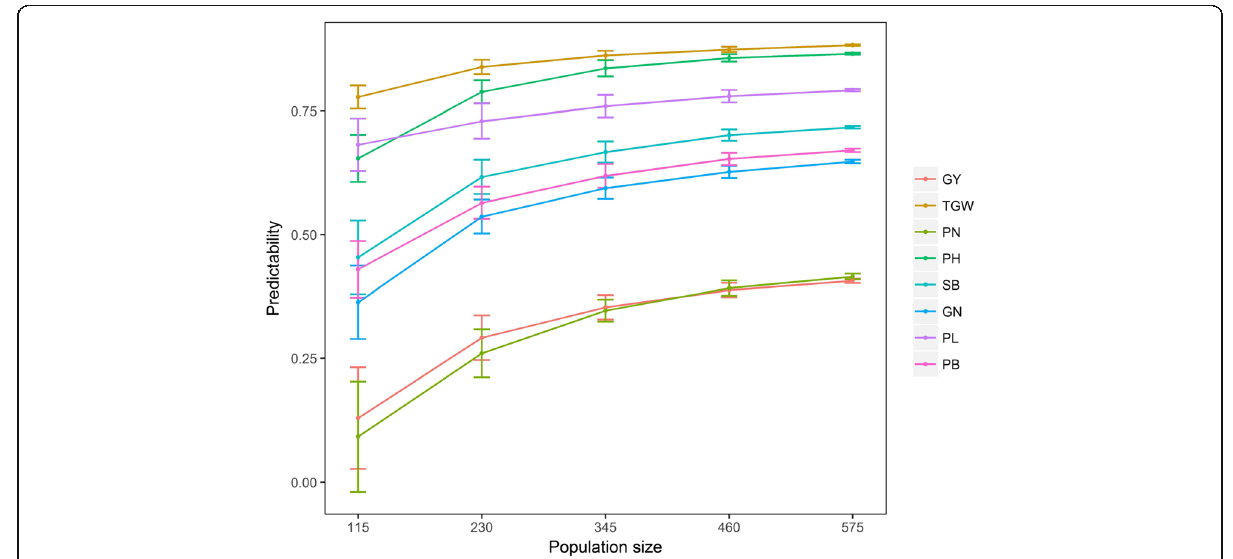
Fig. 4 Effect of the population size on the predictability. Five subsets are selected with the number of individuals varying from 115 to 575. Fivefold cross-validations are repeated 100 times for each subset of the training population. Error bars are constructed using one standard error from the mean